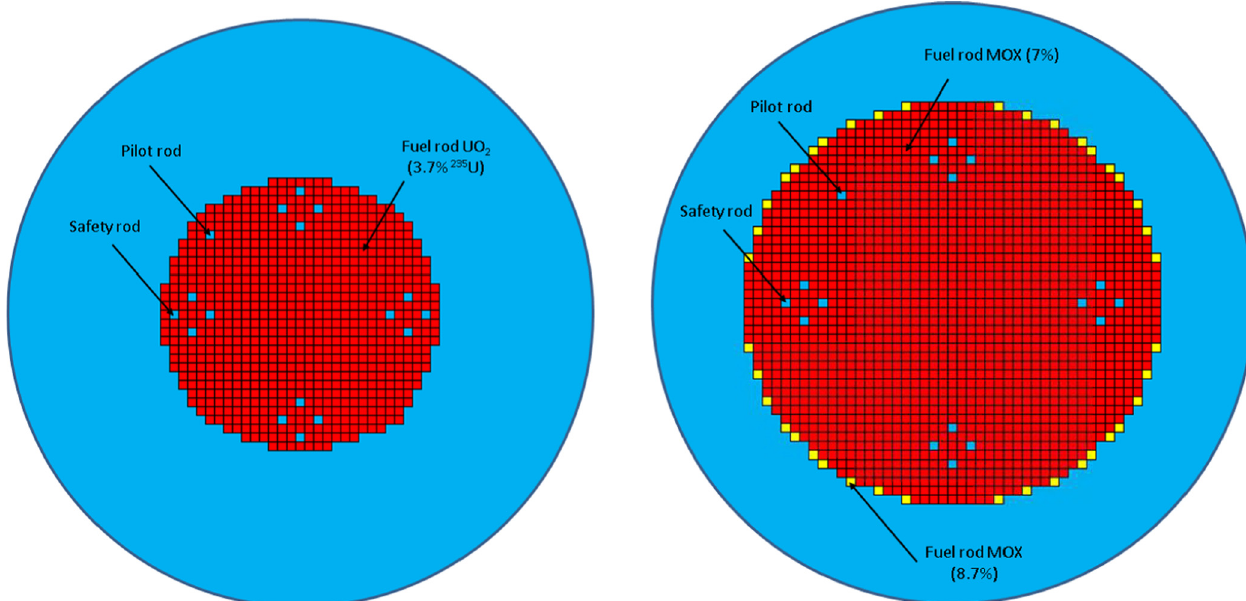
Fig. 9. Radial cross sections of the MISTRAL-1 core (left-hand plot) and the MISTRAL-2 core (right-hand plot) at T = 20 ° C.